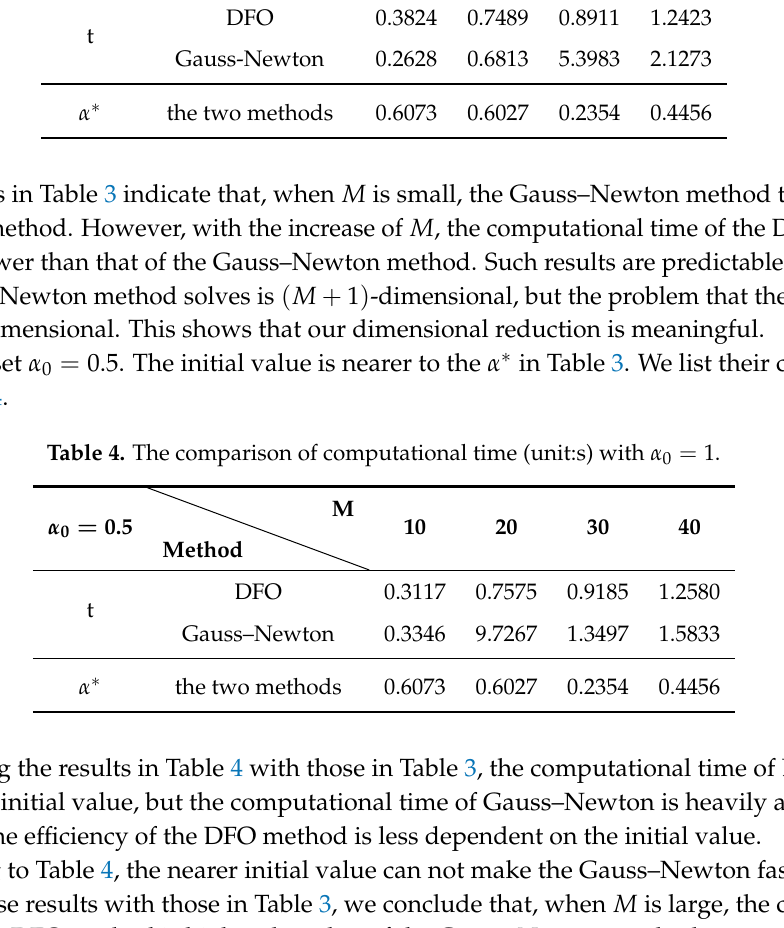
Table 3. The comparison of computational time (unit:s) with α 0 = 1. M 10 α 0 = 1 Method